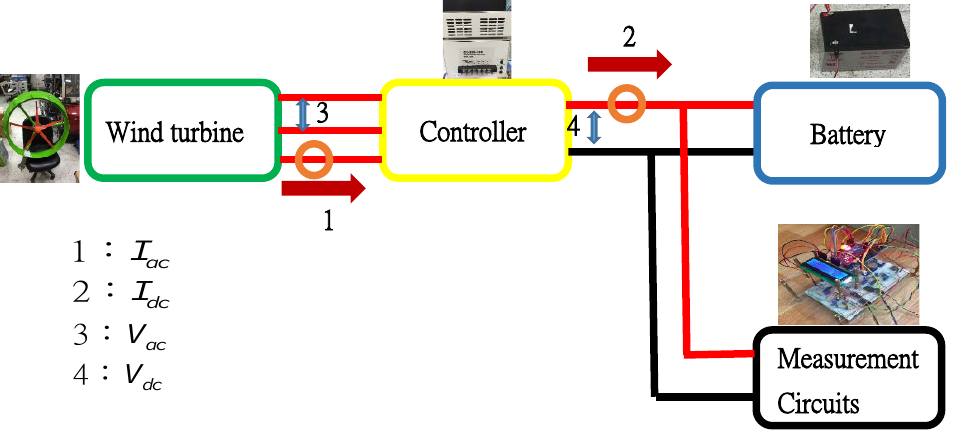
Figure 2. Measurement of the wind power.